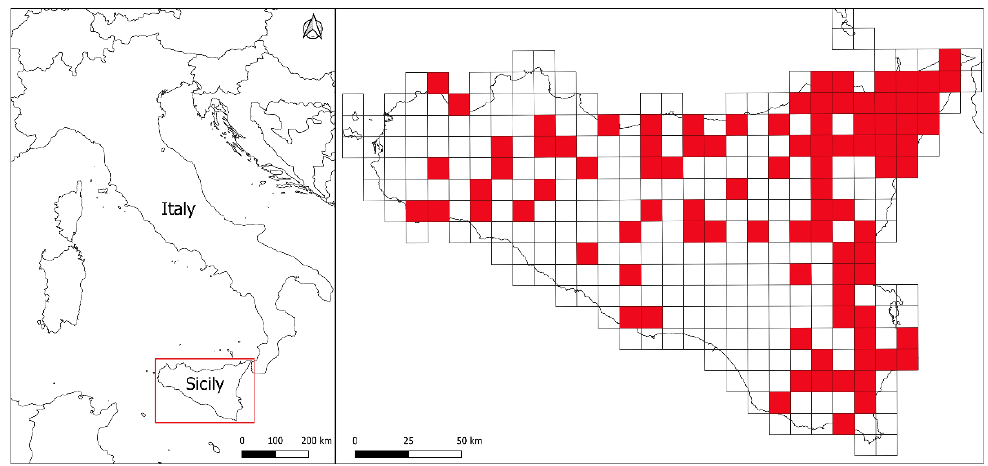
Figure 1. Occurrence sites in the study area based on 10 × 10 km UTM grid square (zone 33N, datum ED50). Both published and novel sites where decapods species were observed are reported.